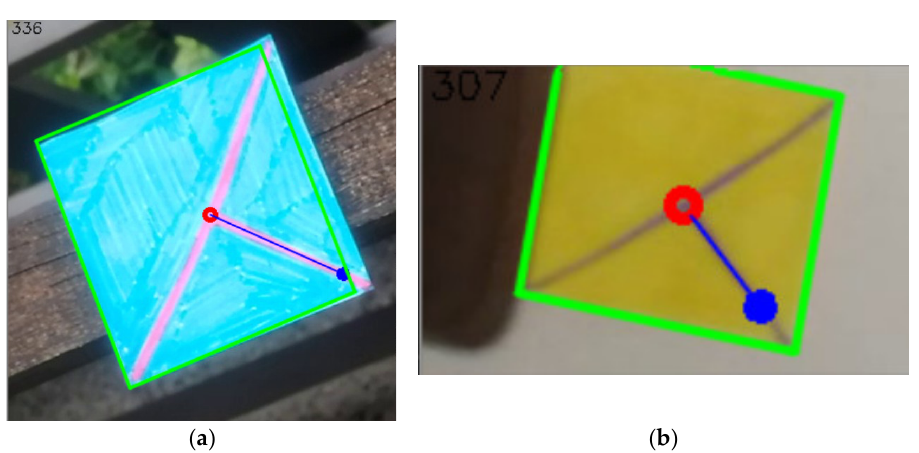
Figure 28. ( a ) the resulting image after getting information of the position (red circle), orientation (blue orientated line, the angle also being written in the left top corner of the image), and size (green outline). ( b ) the same set of information but for a different image.